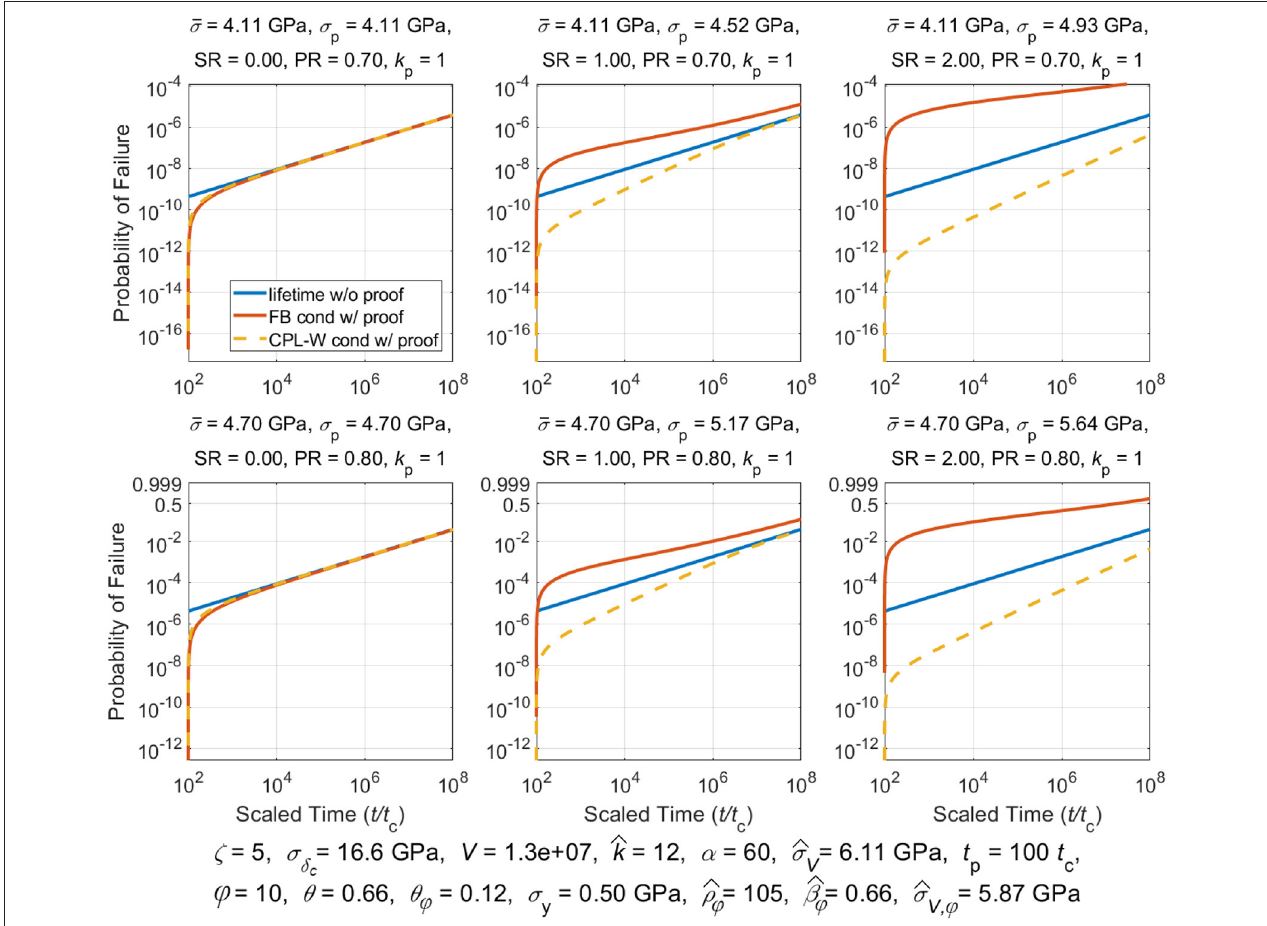
FIGURE 5 | Tows with fibers in a hexagonal array and matrix parameters ϕ susceptible fibers around a cluster.